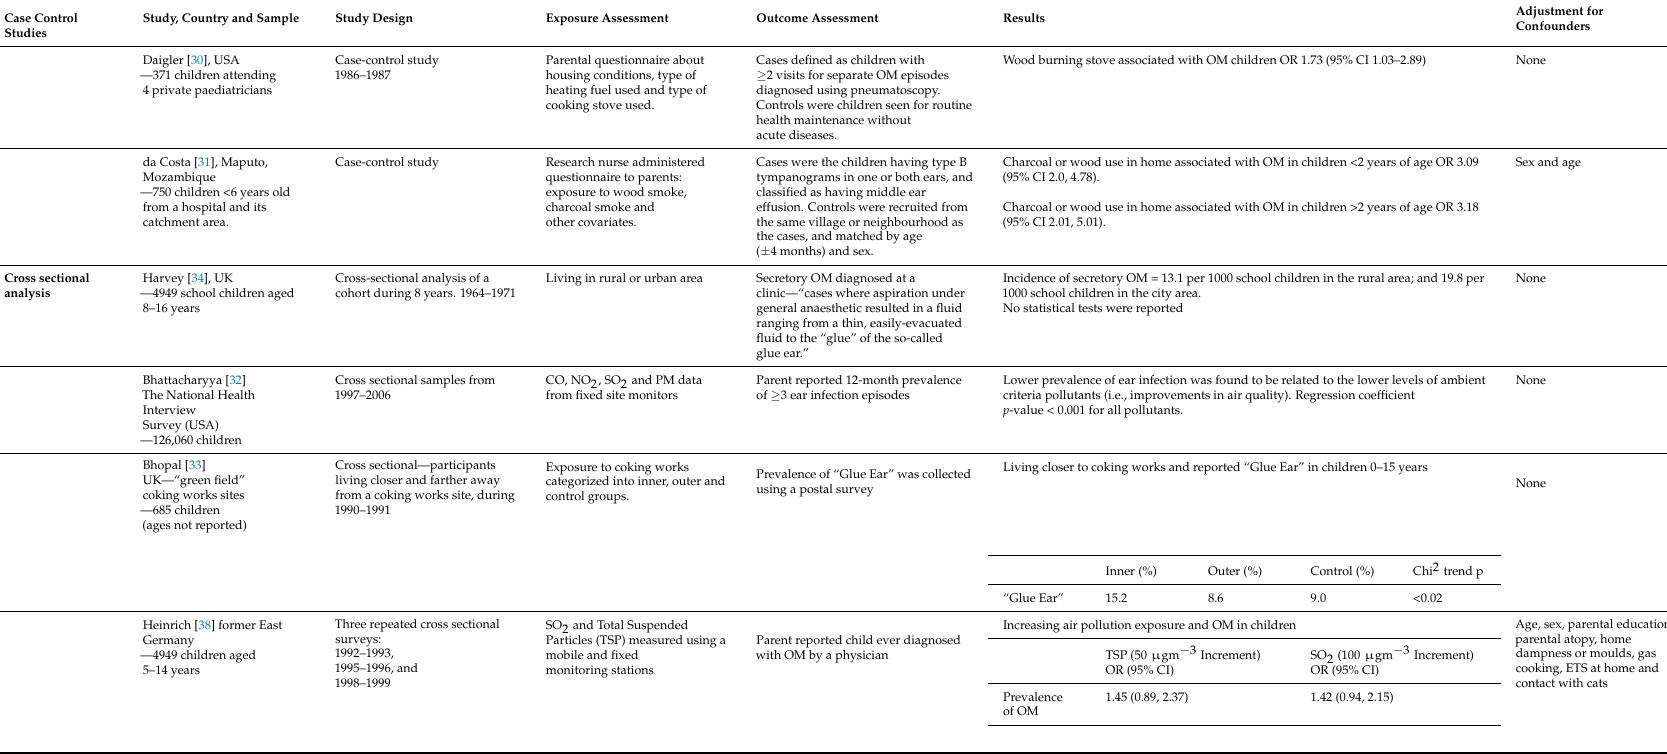
Table 3. Summary of air pollution exposure and otitis media in studies investigating exposure and outcome cross